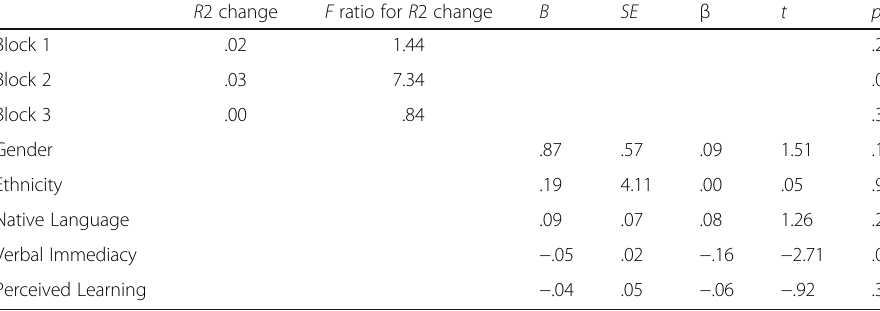
Table 5 Hierarchical multiple regression analysis